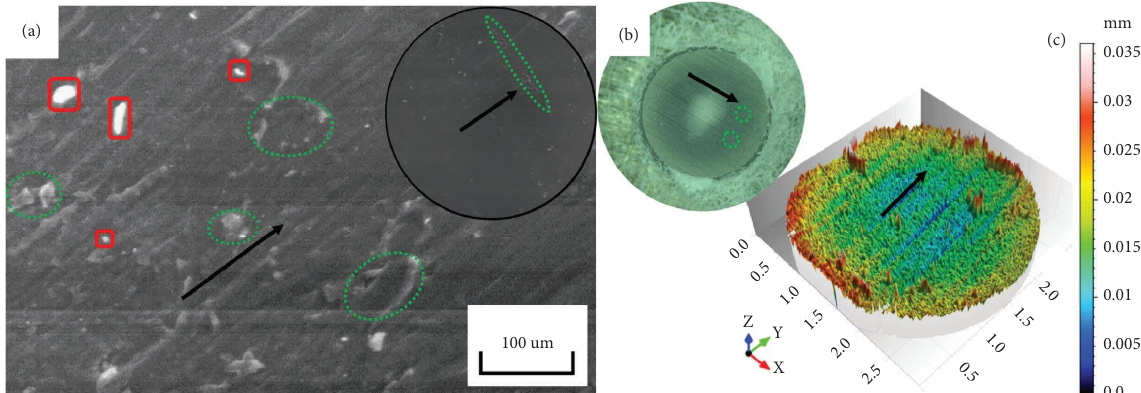
Figure 10: SEM image, optical microscopy, and 3D surface topographies of the wear track of the PP